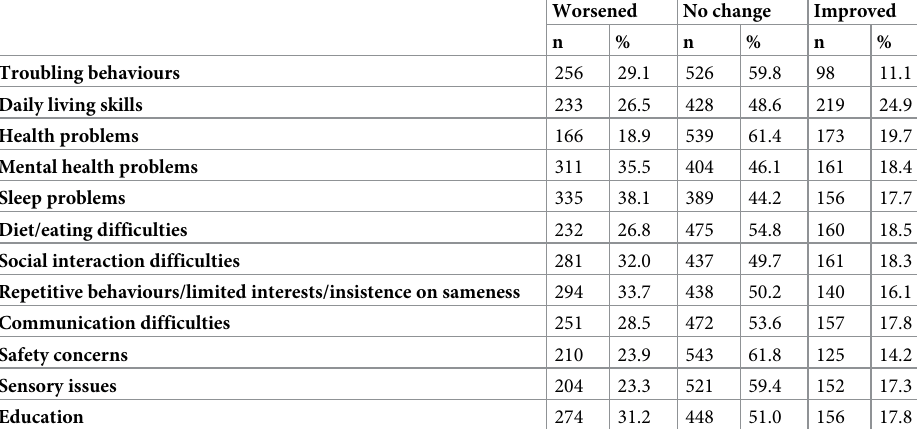
Table 2. Frequency and percentage of caregiver-reported changes in their child by domain of